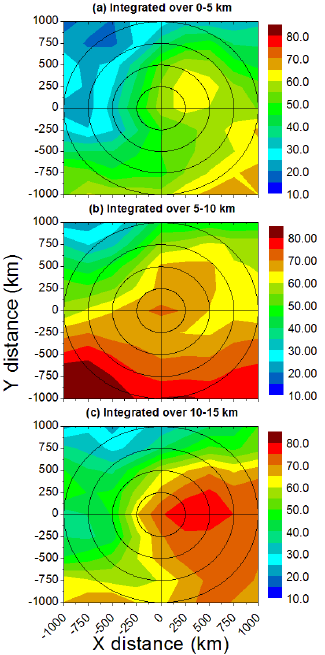
Figure 6. Cyclone-centred composite of averaged RH observed dur- ing TCs (irrespective of TC intensity) in the (a) 0–5km, (b) 5– 10km, and (c) 10–15km layer using COSMIC GPS RO wet pro- files.